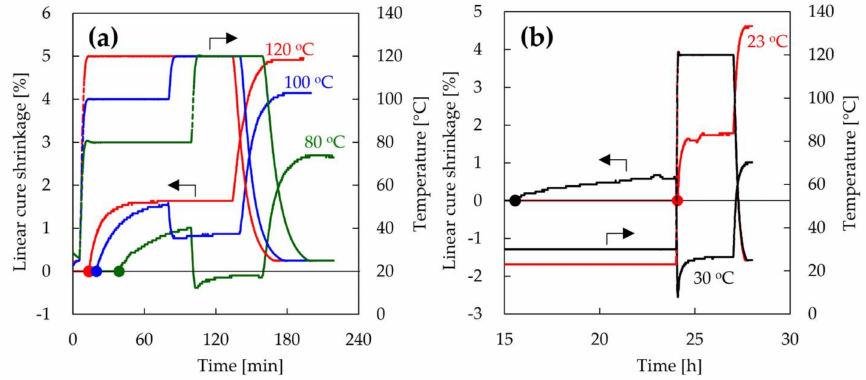
Figure 8. Linear cure shrinkage of epoxy resin as a function of time. Epoxy resin was heated after